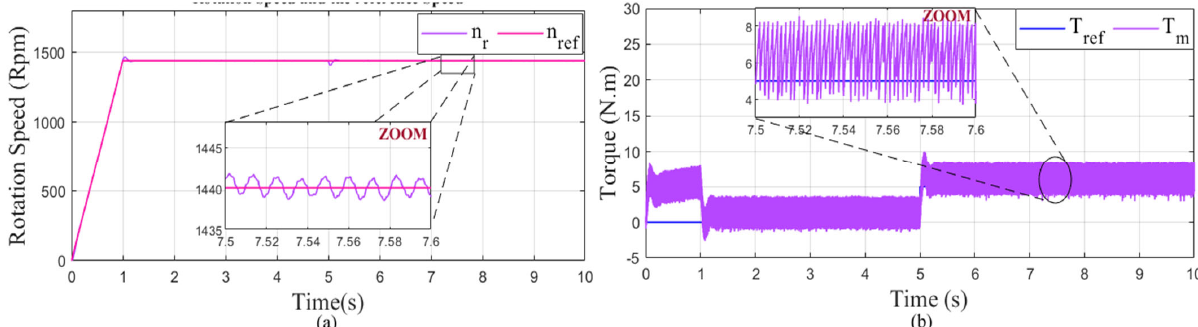
Figure 28. Performance with OR bearing defect of IM with DTC control: ( a ) rotation speed and ( b ) motor torque.